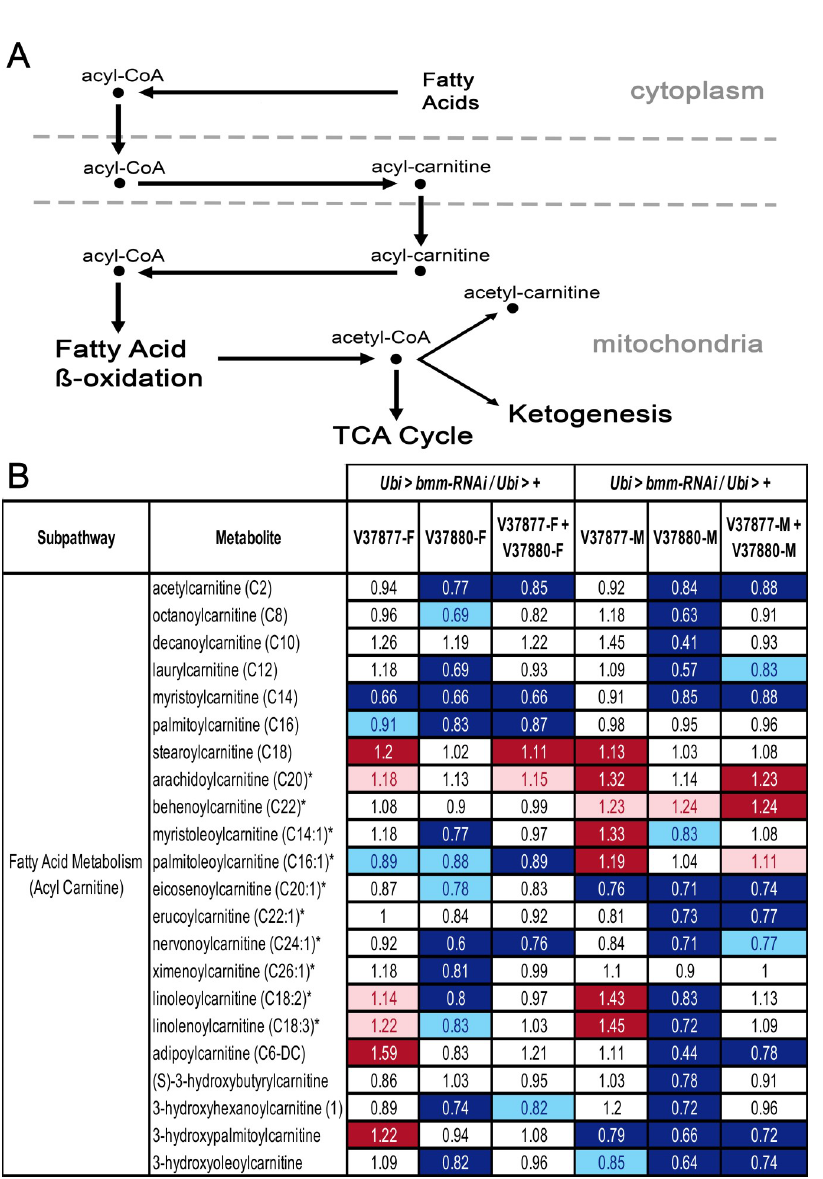
evaluated 175 compounds in 14 amino acid metabolic pathways. Ubi > bmm-RNAi V37877 females had altered quantities of 65 metabolites (58 " /7 # ), while only 39 metabolites changed (27 " /12 # ) in Ubi > bmm-RNAi V37880 females. Ubi > bmm-RNAi V37877 males showed changes in 64 metabolites (54 " /10 # ), while Ubi > bmm-RNAiV 37880 males only showed alterations in 32 compounds (18 " /14 # ).